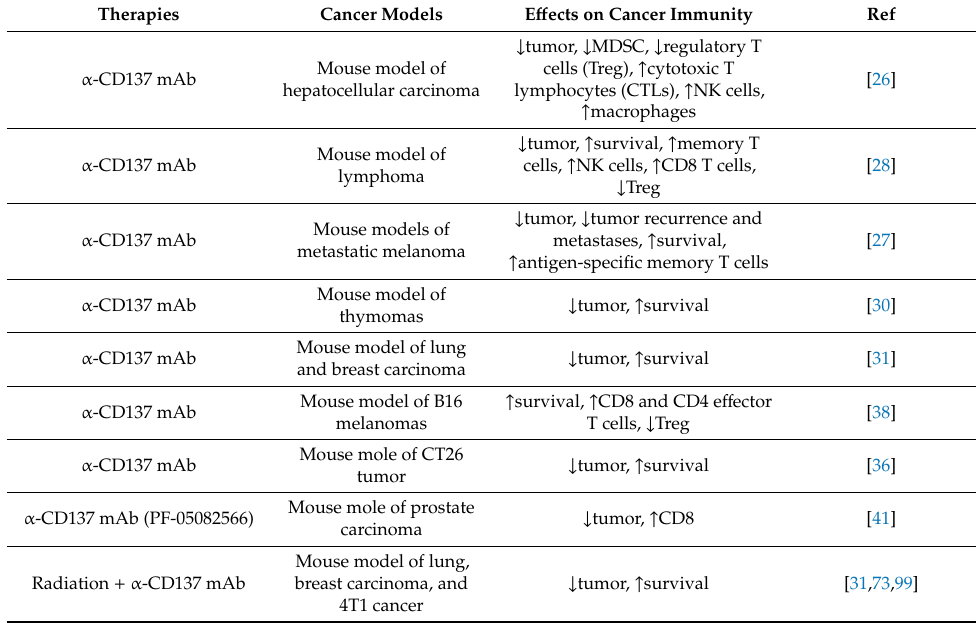
Table 2. The e ff ect of mono anti-CD137 therapy on tumor immunity.